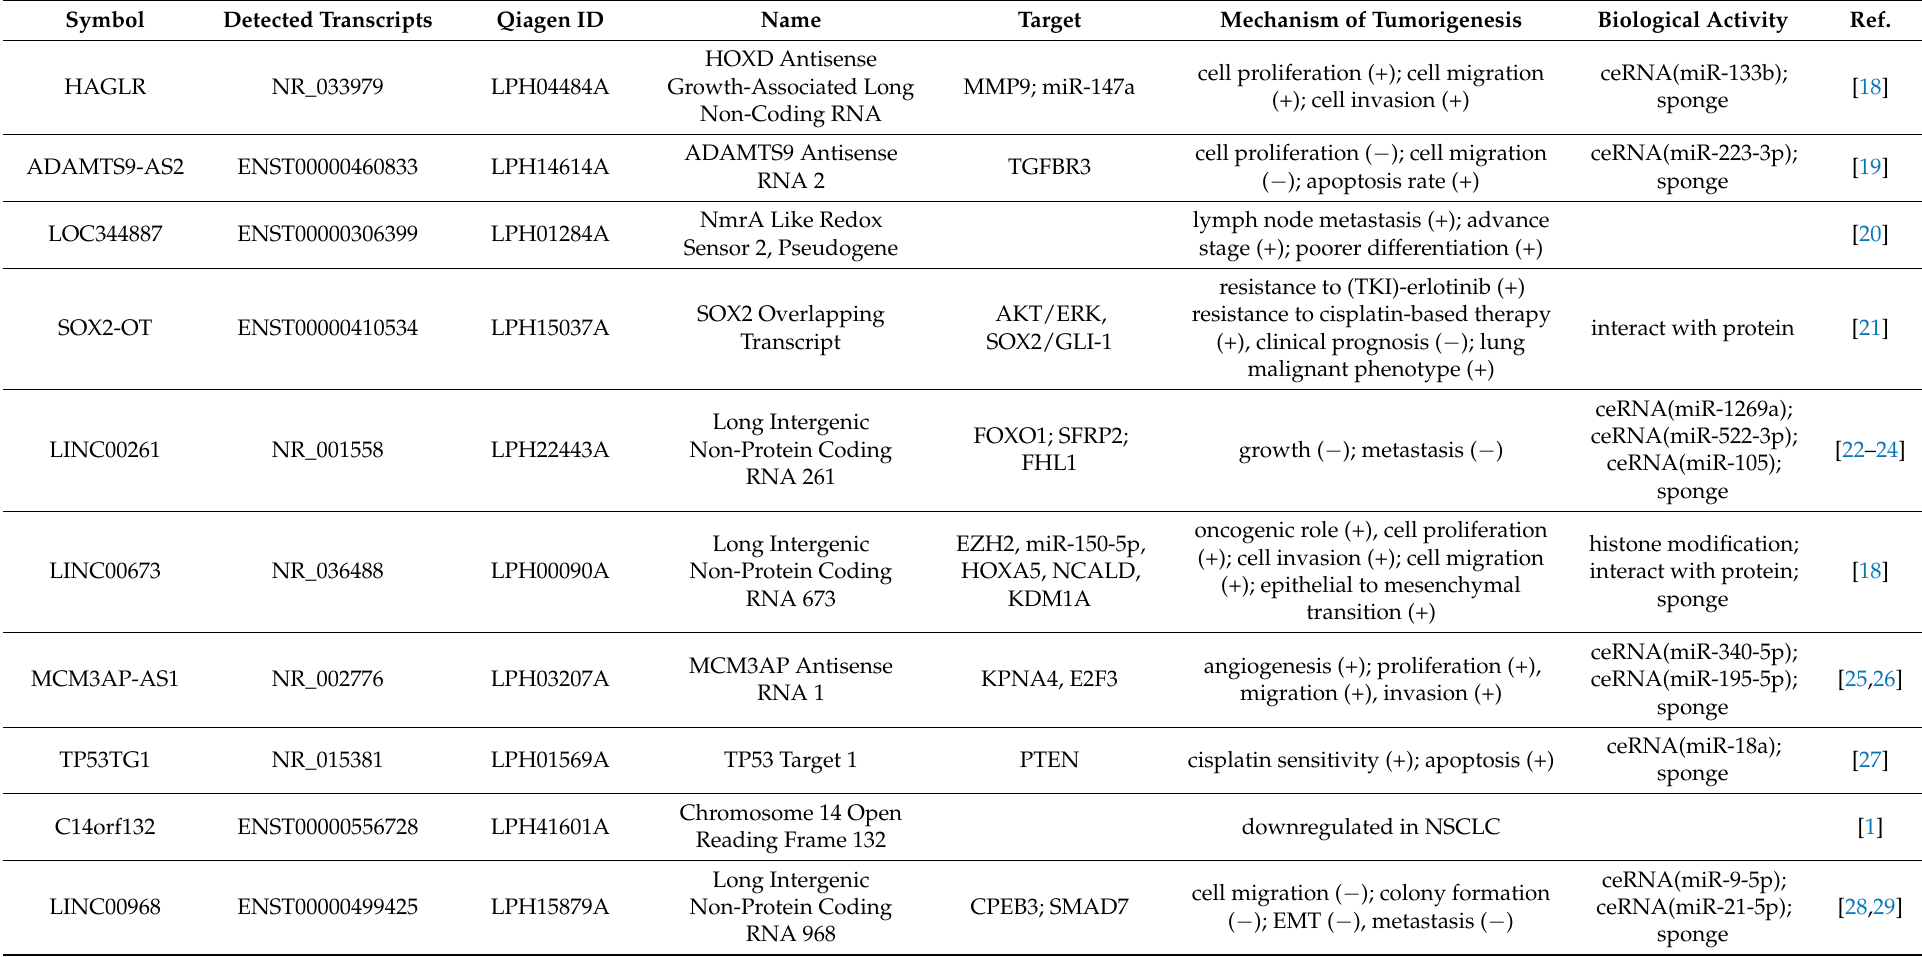
Table 1. The brief characteristics of 14 lncRNA selected for the